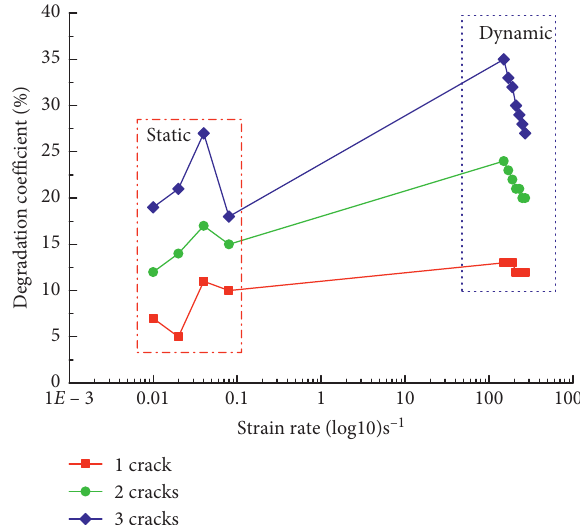
Figure 9: Degradation coefficient with different prefabricated cracks and strain rates.